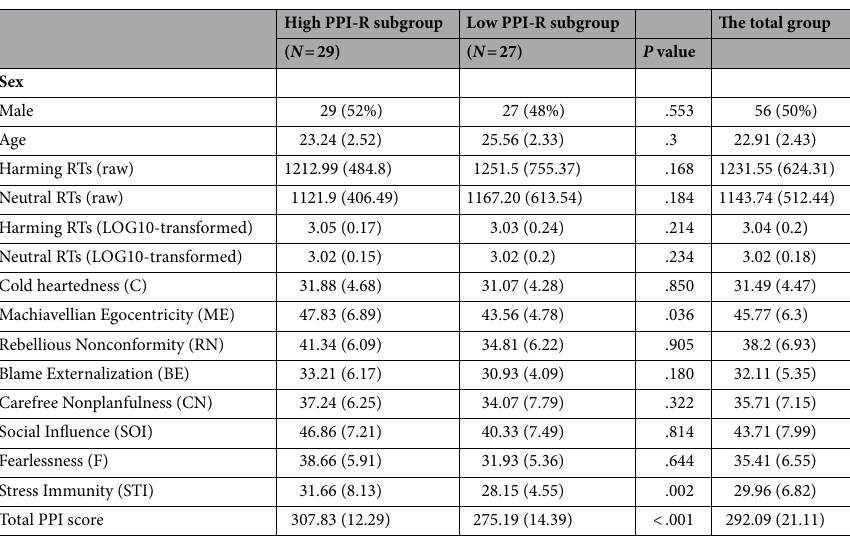
Table 1. Demographic variables of the participants in the study. Participants were divided into subgroups of relatively High ( n = 29) and Low ( n = 27) PPI-R total scores based on mean and median split. PPI-R, Psychopathic Personality Inventory-Revised. Data are presented as mean (SD) or number of participants